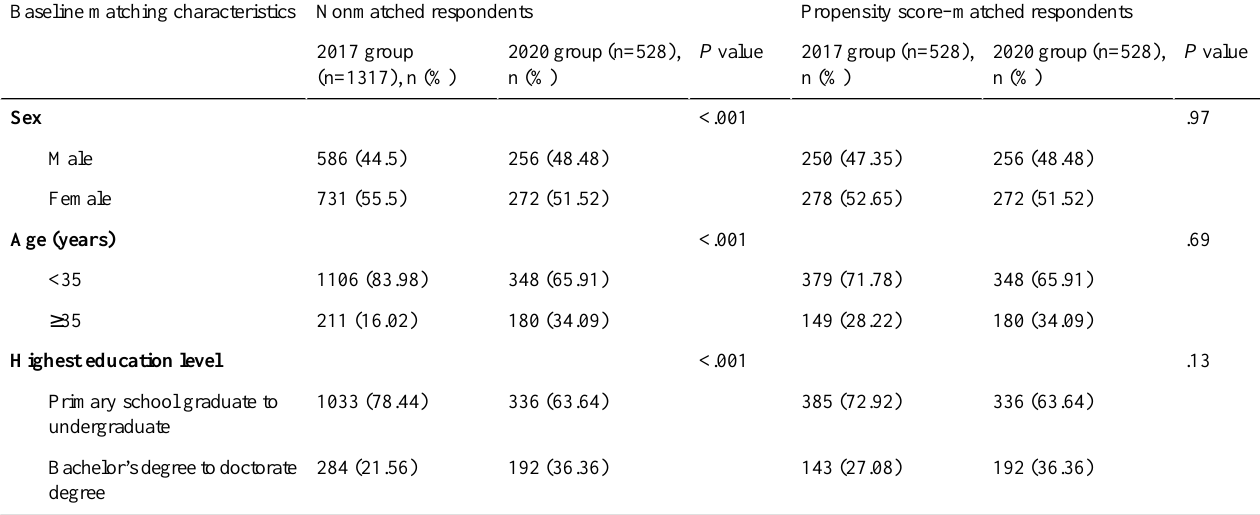
Table 1. Demographic characteristics of nonmatched and propensity score–matched